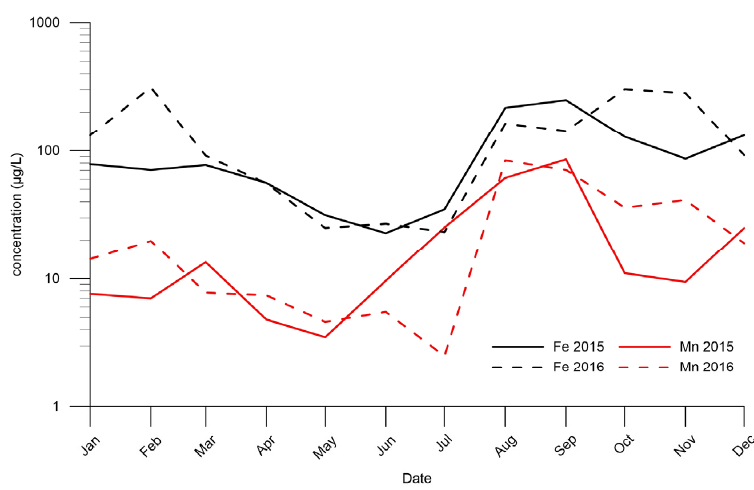
Figure 10. FeTOT and Mn (µg/L) concentrations at the water treatment plant at Capaccio in 2015 and 2016.